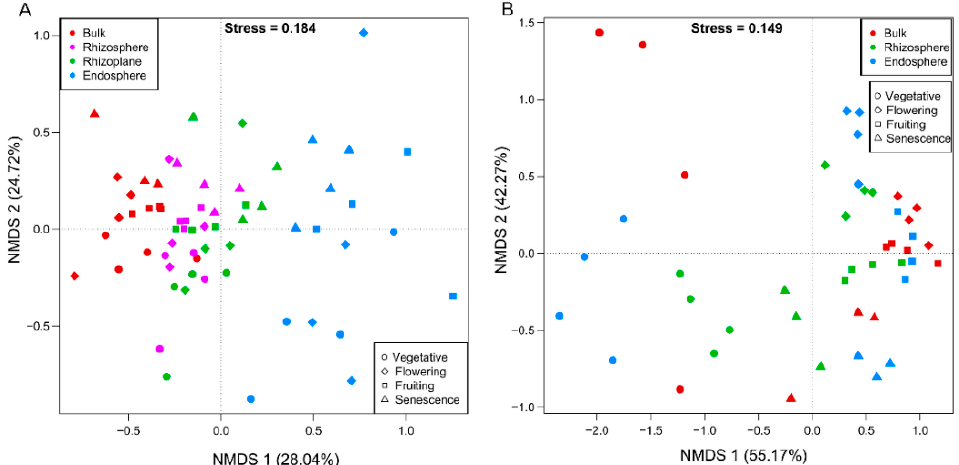
Figure 4. Non-metric multi-dimensional scaling plots indicate that the largest separation between microbial communities is spatial proximity to the root compartment for bacterial communities ( A ) and growth stage for fungal communities ( B ). The meanings of symbols and color are the same with Figure